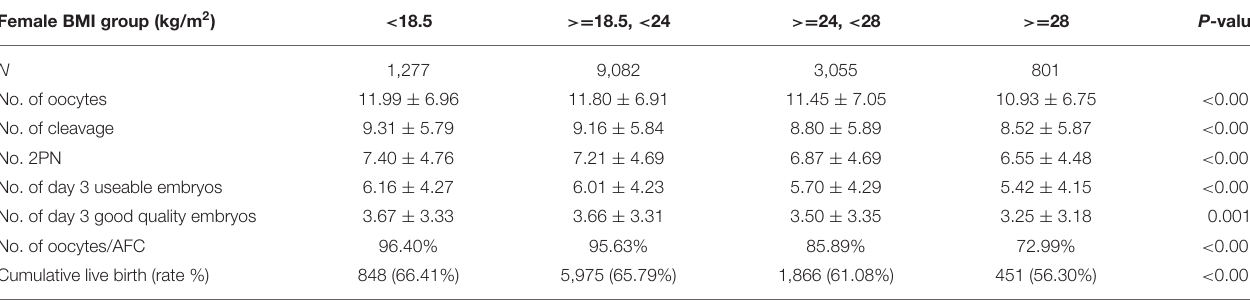
TABLE 2 | Oocytes and embryo parameters and cumulative live birth rates.